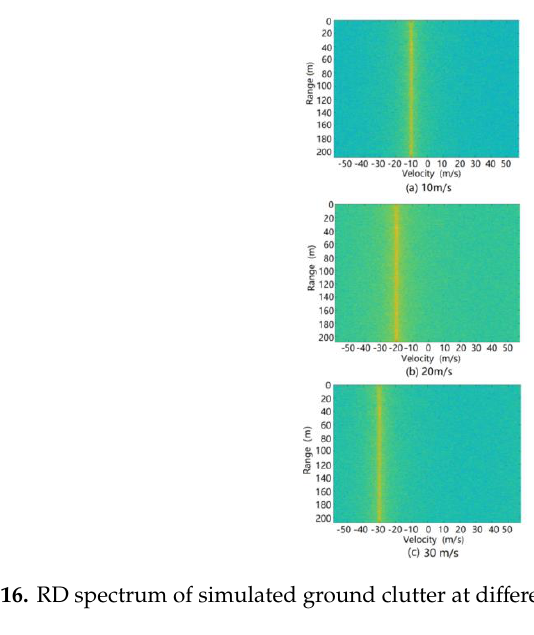
Figure 17. Position of stationary vehicle in RD spectrum of ground clutter during simulation. Using the classical processing algorithm of the actual vehicle intelligent driving millimeter wave radar on the original simulation results of the ground clutter RD spectrum, we successively carried out moving target detection (MTD) processing, constant false-alarm rate (CFAR) detection and processing, and digital beam forming (DBF) processing. The original simulation results for the ground clutter RD spectrum at different relative speeds after MTD processing are shown in Figure 18. It can be seen from this figure that the simulation results for the ground clutter RD spectrum after MTD processing not only reflected the real-time distribution characteristics of the ground clutter simulation scene but also introduced inherent